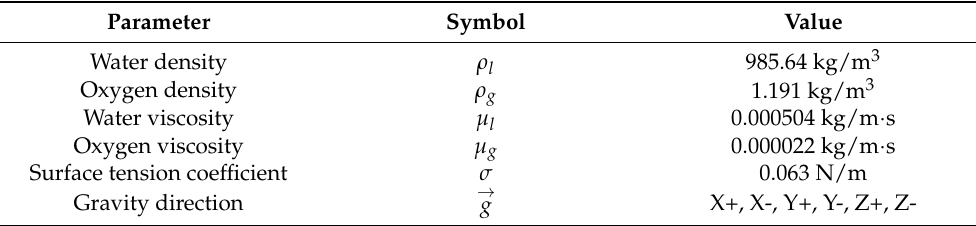
Table 3. Parameters used in the conservation equations of the PEMWE model.